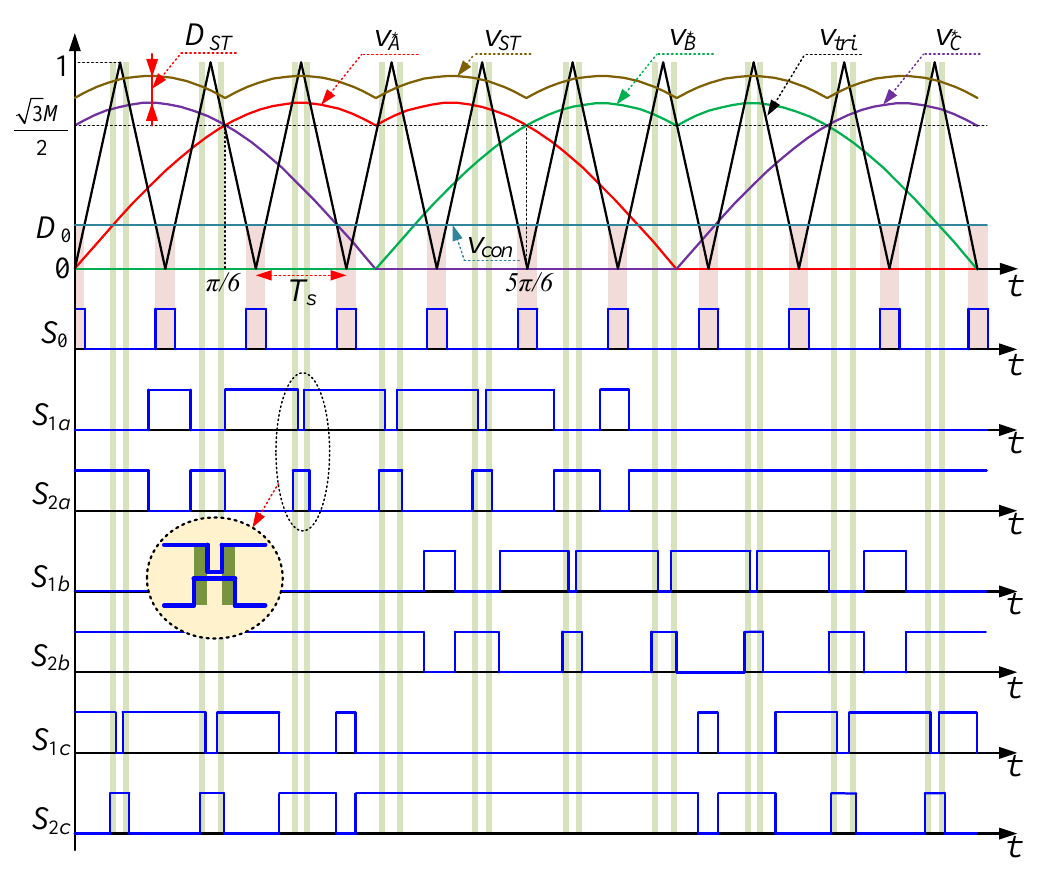
Figure 3. Proposed DPWM for introduced inverter.